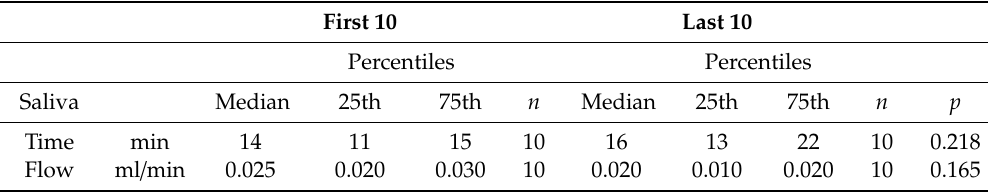
Table 3. Unstimulated parotid saliva sampling time and saliva flow in 45 patients with juvenile idiopathic arthritis and 16 healthy sex- and age-matched healthy individuals comparing the ten first and last sample